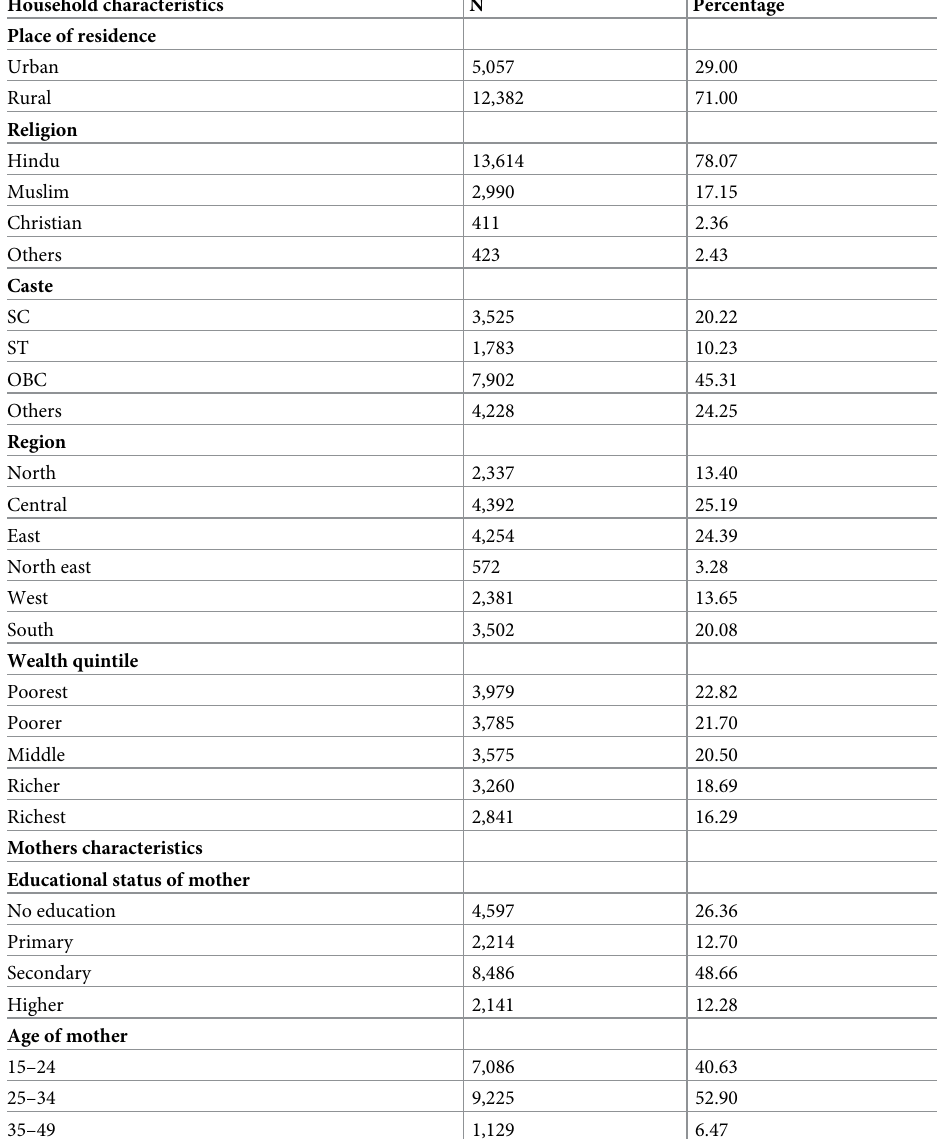
Table 2. Descriptive statistics of the cohort, NFHS-4, 2015–16 (weighted